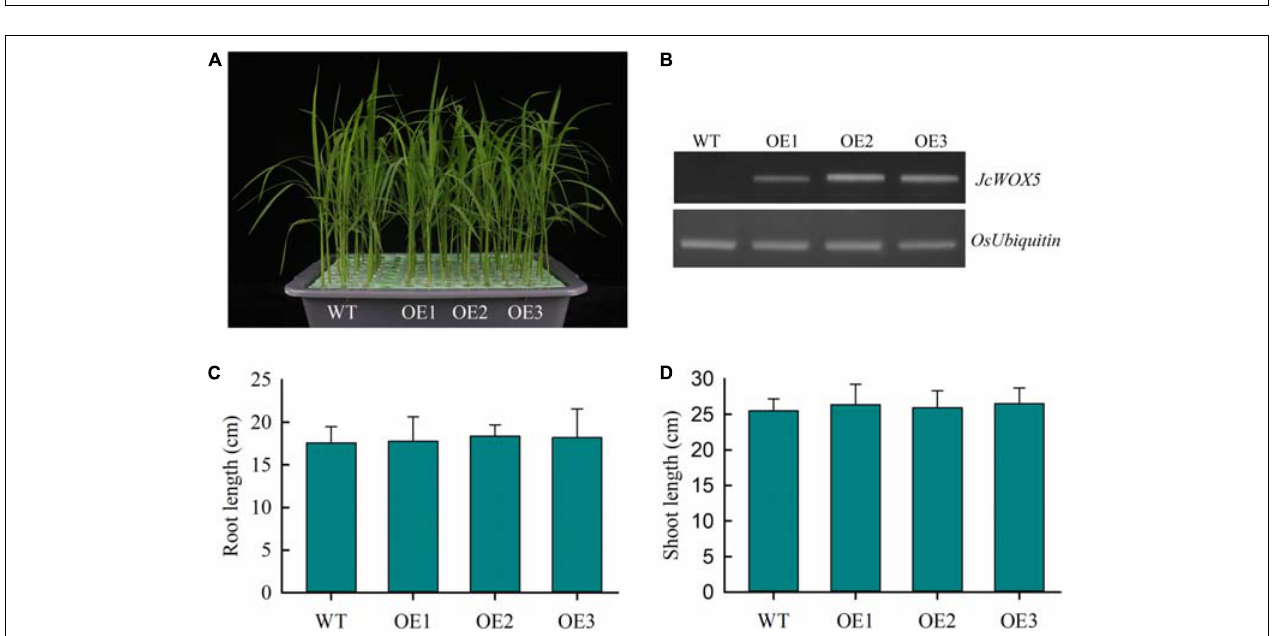
FIGURE 6 | Subcellular localization of JcWOX5. The recombinant vector 35S:JcWOX5-YFP and the vector control was individually infiltrated into Arabidopsis protoplast cells. The fluorescence was observed under a laser scanning confocal microscopy. Scale bar: 10 µ M.